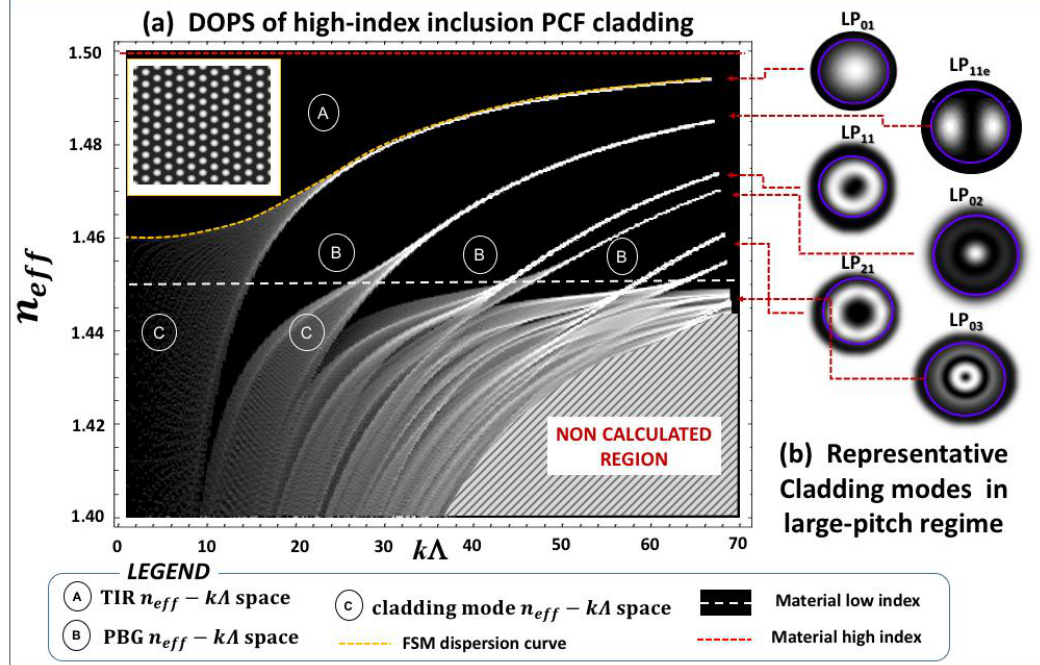
Figure 8. ( a ) Density of photonic state of high inclusion PCF. The PCF structure consists of a glass material with a uniform index n g = 1.45 (dashed horizontal line) and high index cylindrical-shaped inclusions with diameter d hi = 0.46 × Λ and index of 1.5; ( b ) The intensity profile of representative cladding modes shown within the Wigner-Seitz unit